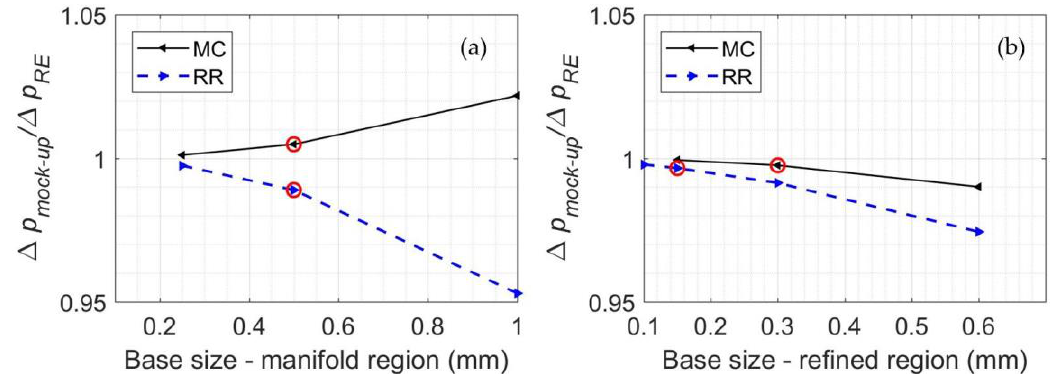
Figure 12. Grid independence analysis on the pressure drop computed for the mock-ups, varying the base size in the water manifolds ( a ) and the base size in the refined region ( b ), for a flow rate corresponding to 1.16 × 10 −3 m 3 /s in the full mock-up. The red circles highlight the values selected for the simulations in the present analysis. Table 1. Topological details of the computational grids developed for the MC and RR models.